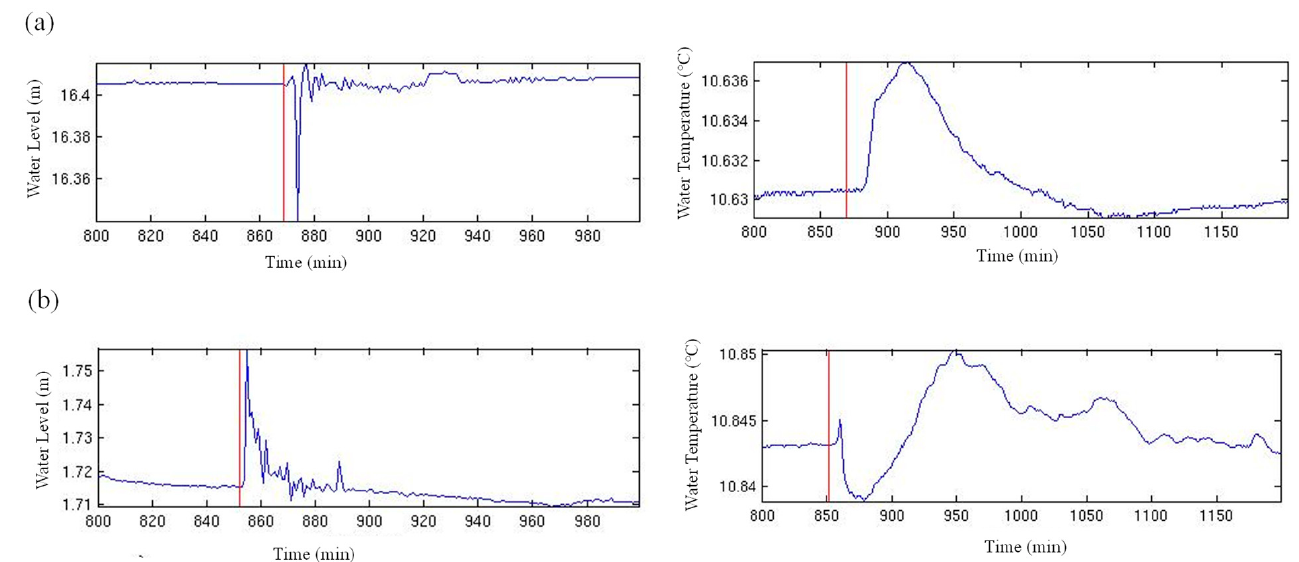
Figure 7. Response to occurrence (red line) of large earthquakes. ( a ) The M8.0 Wenchuan great earthquake on 12 May 2008. ( b ) M8.1 earthquake that occurred in Nepal on April 25th, 2015.